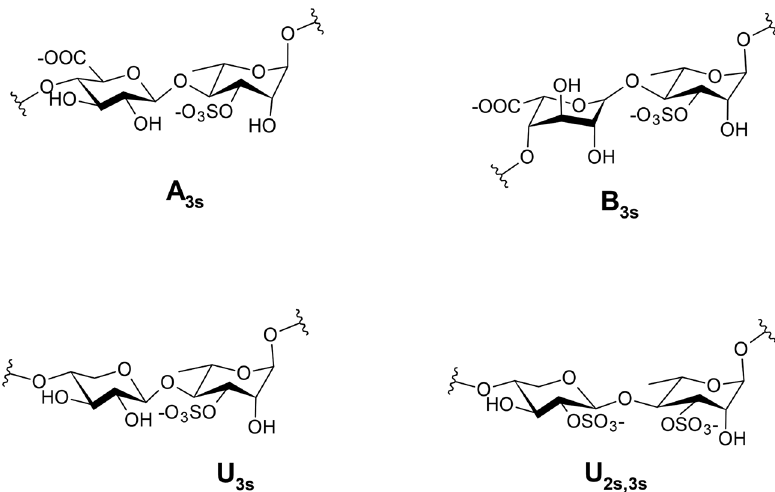
Figure 5: Structure and nomenclature of the main repeating disaccharides: ulvanobiuronic acids ( A 3S and B 3S ) and ulvanobioses ( U 3S and U 2S,3S )